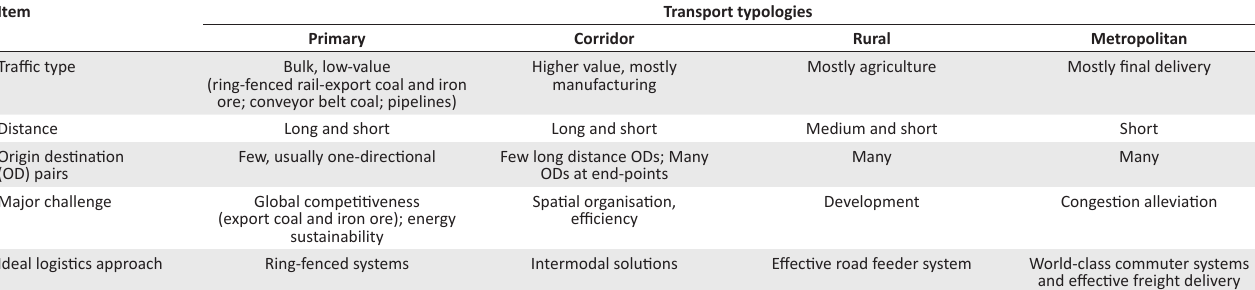
TABLE 1: Definition of transport